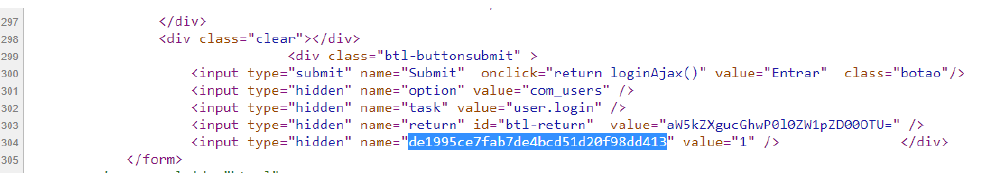
Figure 4. Hash values of content associated with different requests for a “static” URL.